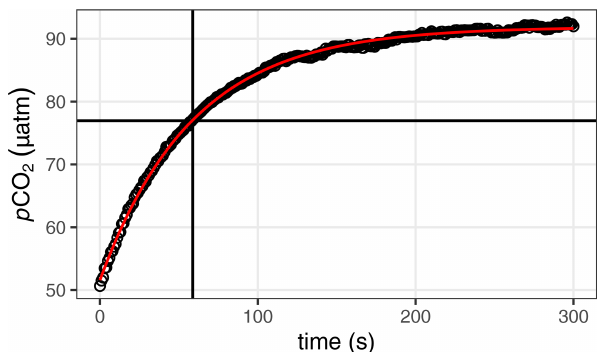
Figure A1. Exemplary determination of the response time τ through fitting an exponential function (red curve) to the p CO 2 signal recovery following a zeroing measurement. The determined response time τ and p CO 2 (t = τ) are indicated by a vertical and horizontal line,